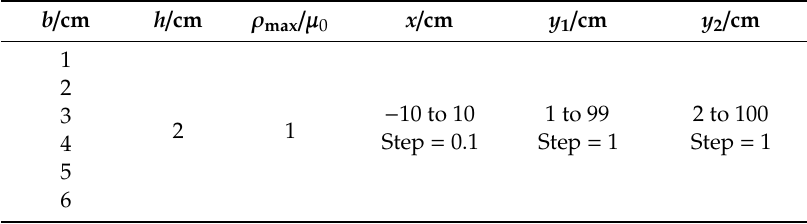
Table A4. The parameter list of MATLAB finite element calculation in Figure 5.